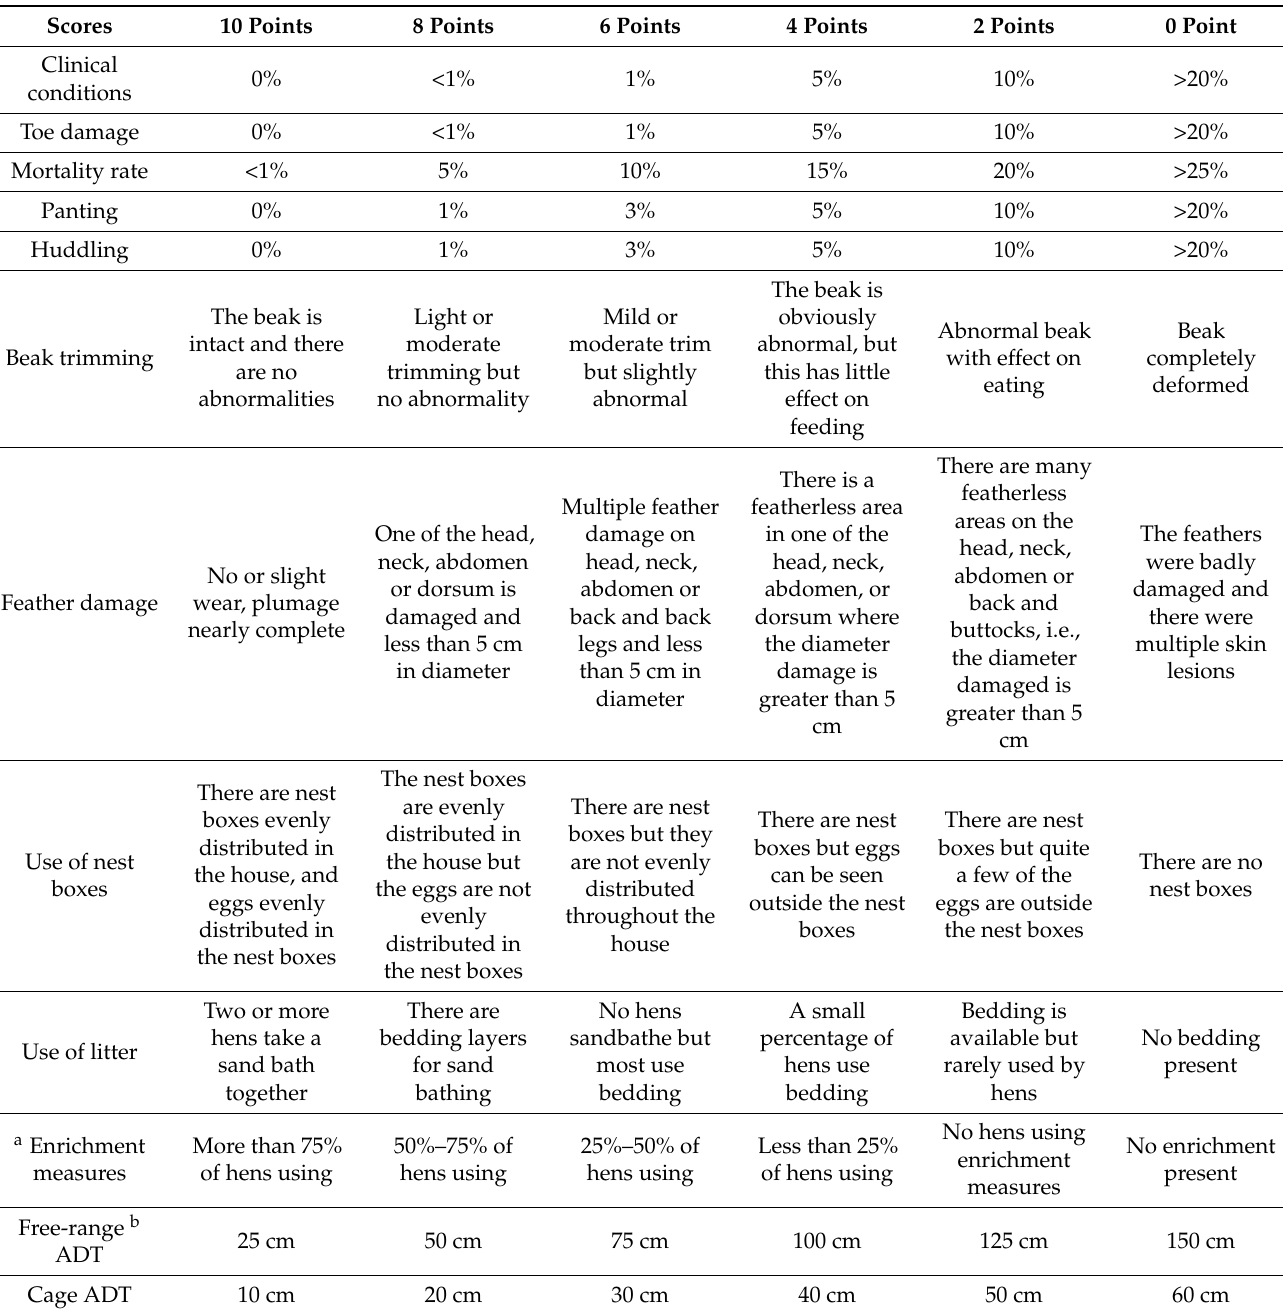
Table 3. Scoring for health condition and behavioral indicators of hen